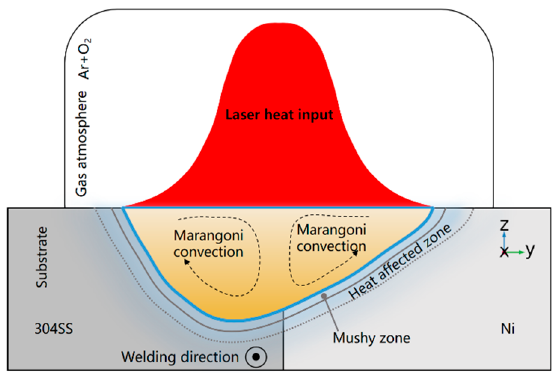
Figure 2. Diagram of laser dissimilar welding of 304SS–nickel couple in an argon–oxygen mixed atmosphere. Table 2. Welding parameters.